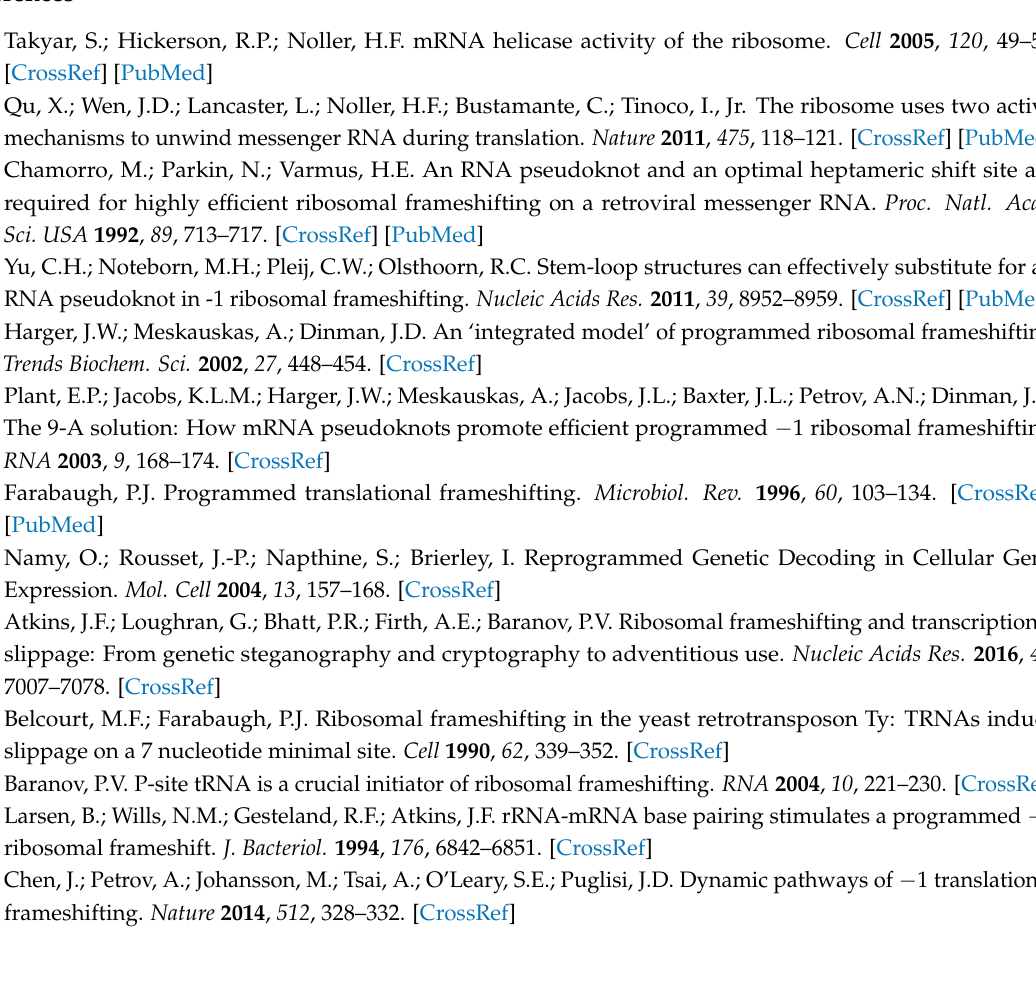
Figure S1: t Radioactivity-based frameshifting analysis of a − 1 PRF model system using GST-Rluc-1 reporter by in vitro translation in cell-free lysates of E. coli., Figure S2: The +1 frameshifting stimulated by duplex structures upstream of the CUUUGA frameshifting site are abolished in the presence of RF2., Figure S3: Potential RNA-protein adducts disappear upon RNase A treatment., Figure S4: Recovery of a potential − 1 frame translation product for mass spectrometry analysis., Figure S5: RNase A treatment removes a low mobility band without affecting the three major translation products., Figure S6: Creating a cysteine hungry codon by reducing cysteine amino acid concentration in the in vitro translation